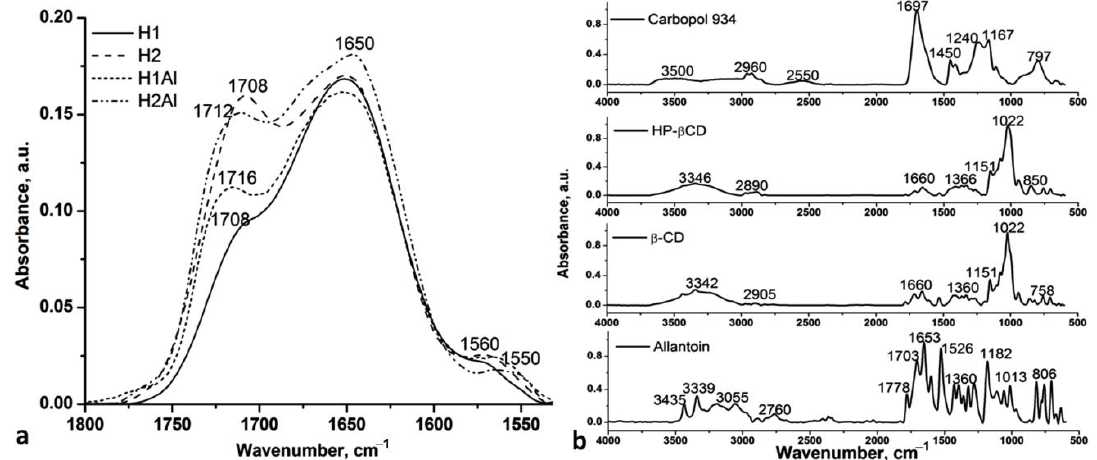
Figure 1. Carbonyl and amide II spectral regions of H1, H2, H1Al, and H2Al samples ( a ) and the comparative spectra of allantoin, β -CD, HP- β -CD, and Carbopol 934 ( b